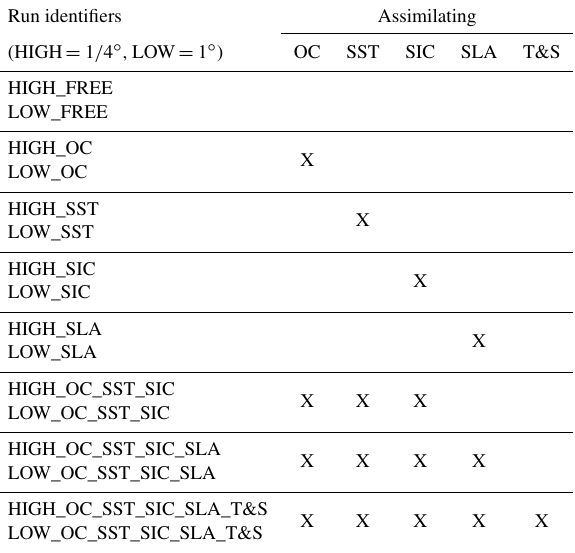
Table 1. Summary of model runs performed. SST refers to satellite data only; in situ SST and profile data are included with T&S. HIGH and LOW are intended as relative